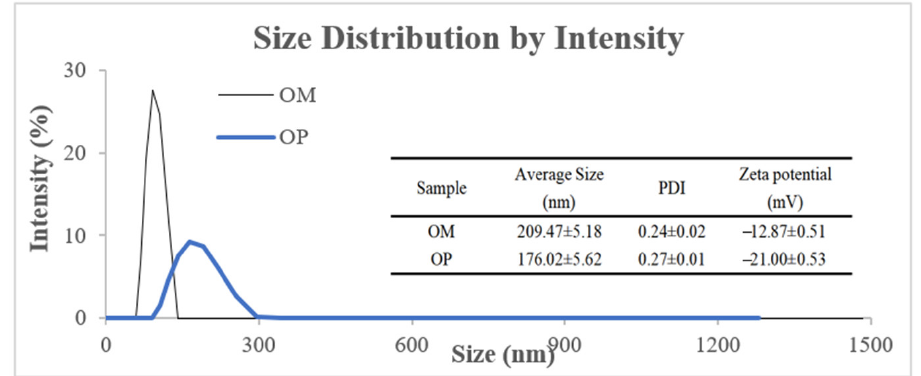
Figure 1. Particle size distribution and zeta potential of OM and OP .